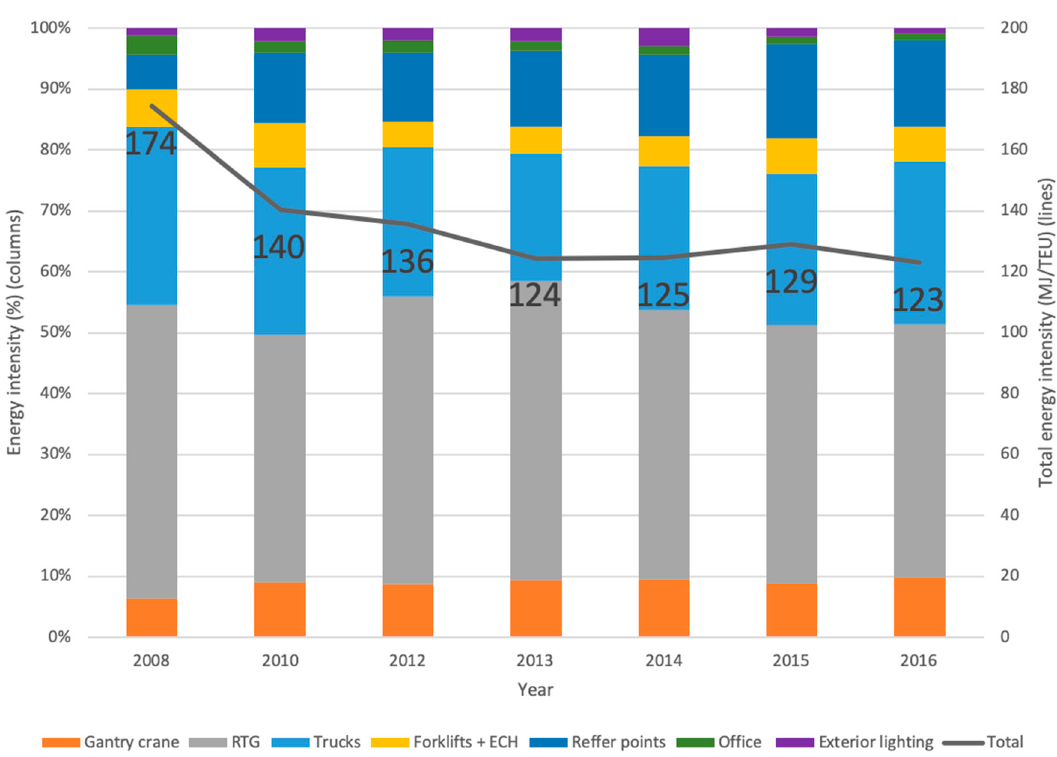
Figure 6. Energy intensity results for the case study using TEU as the functional unit.